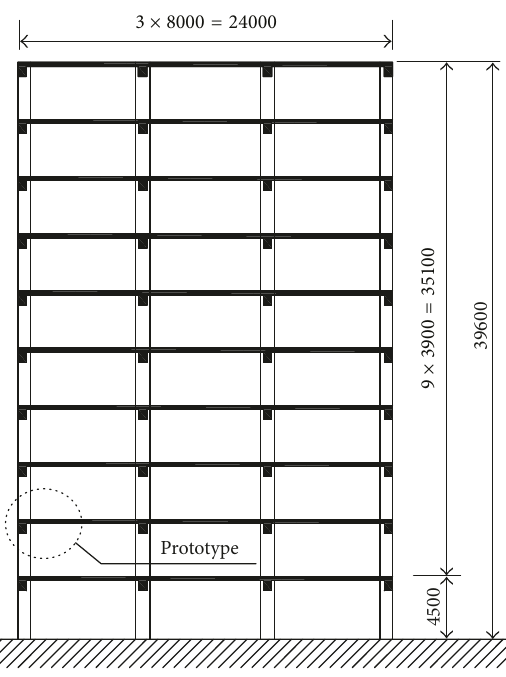
Figure 1: A typical RC 10-story